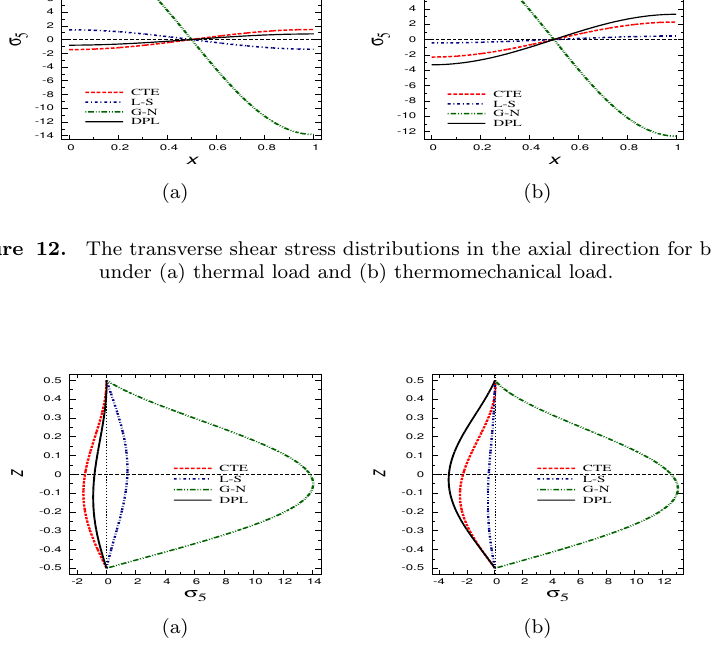
Figure 13. The transverse shear stress distributions in the thickness direction for beams under (a) thermal load and (b) thermomechanical load.